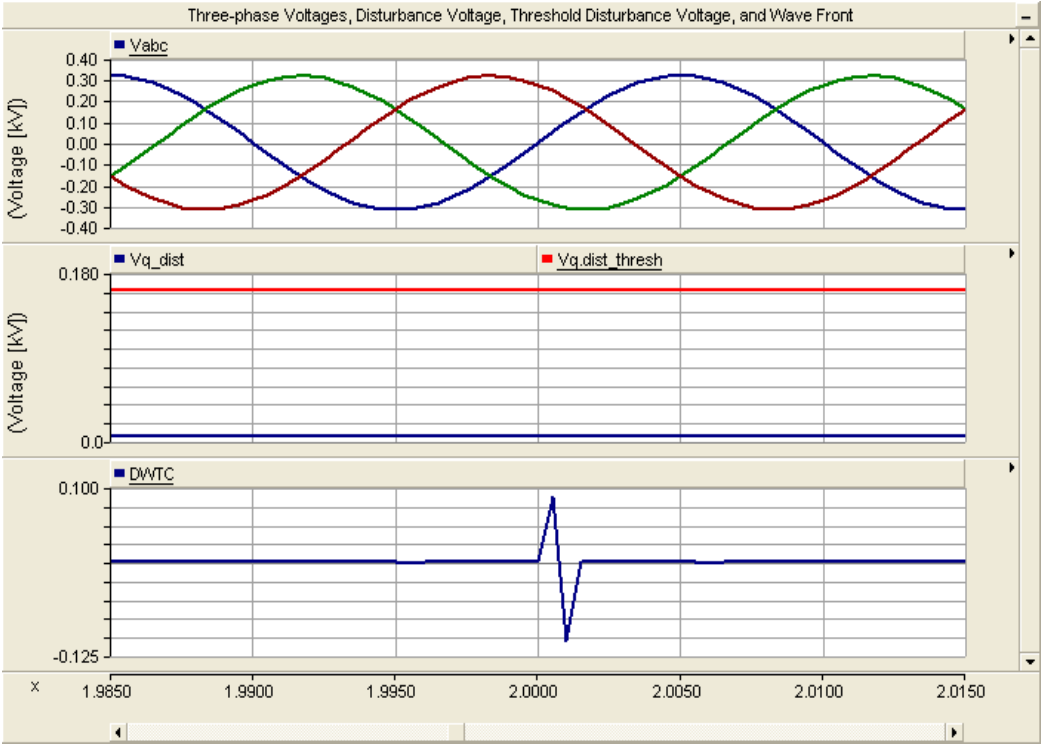
Figure 6. 3-phase voltage, disturbance voltage, and DWTC during F4.